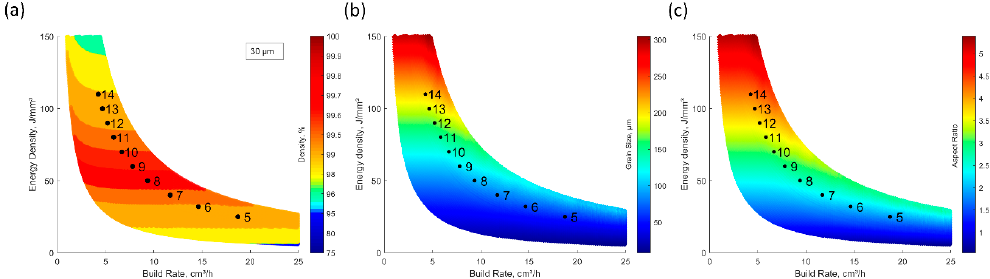
Figure 7. Processing maps for the Ti-Zr-Nb alloy: ( a ) density, ( b ) grain size and ( c ) grain aspect ratio; (hatching distance 110 μ m; Specimen 14 is shown in ( a ), but not in ( b , c ) (explanations in text)).